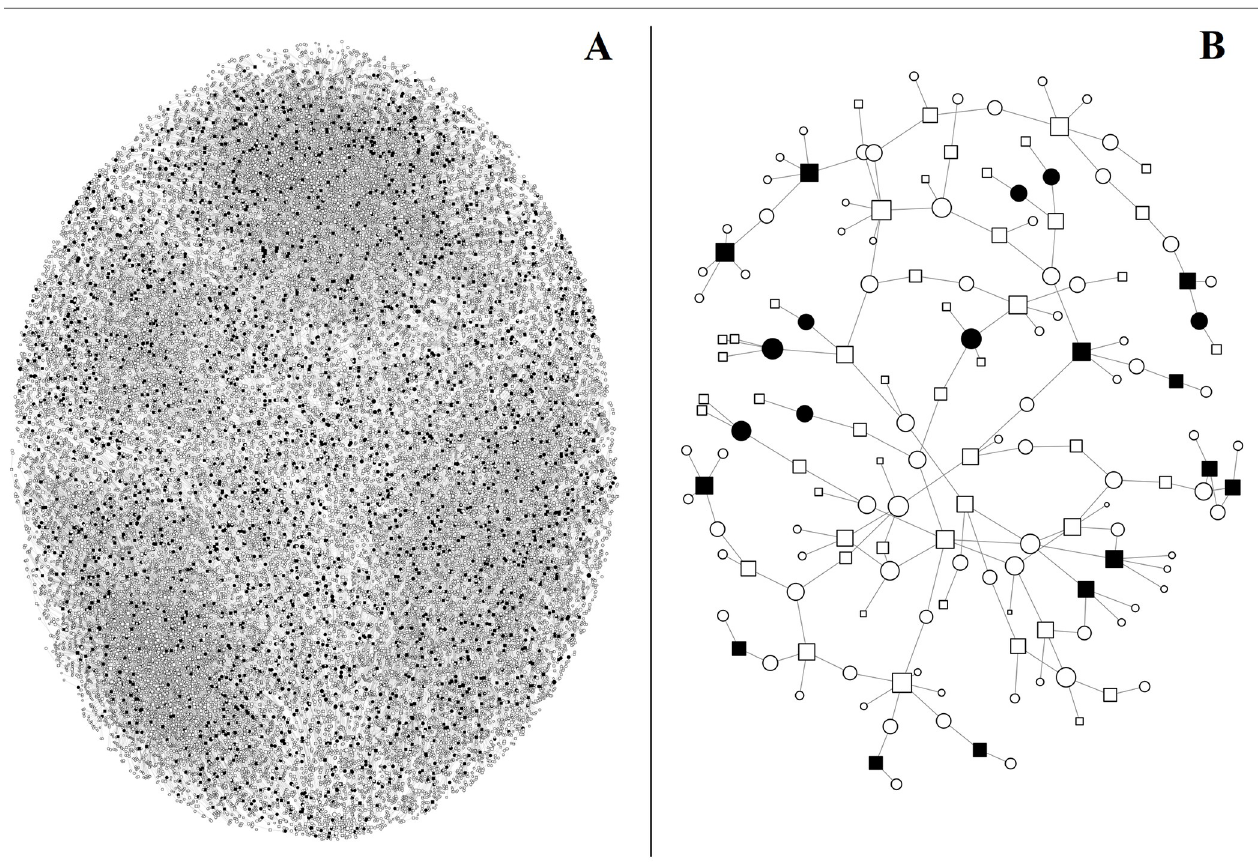
Fig 2. Sociogram of two largest network components. A indicates the largest network component; B indicates second largest network component. Networks are constructed from all opioid prescription ties from October 1, 2008 to June 30, 2009. Nodes are sized according to their BiRank centrality. Circular nodes indicate patients; square nodes indicate providers. To highlight the discrepancy between BiRank and PageRank estimates for the same nodes, the nodes are colored black if their BiRank value is two standard deviations above the mean BiRank value and if their PageRank value is below the mean PageRank value.